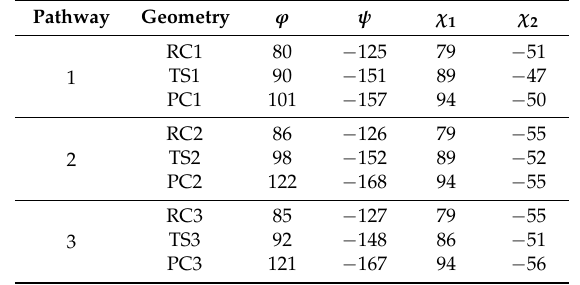
Table 1. The main-chain dihedral angles ϕ and ψ , and the side-chain dihedral angles χ 1 and χ 2 (in degrees) of the optimized geometries 1 Table 1. The main ‐ chain dihedral angles φ and ψ , and the side ‐ chain dihedral angles χ 1 and χ 2 (in degrees) of the optimized geometries 1 .